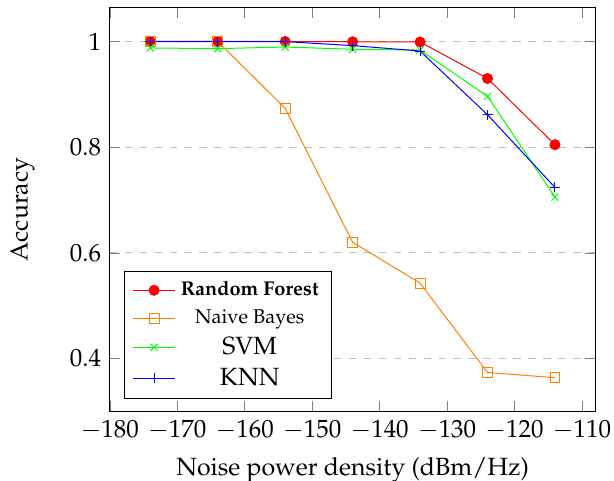
Figure 9. Graphic of the accuracy of the RF in comparison with classical machine learning approaches with N 0 between − 114 dBm/Hz and − 174